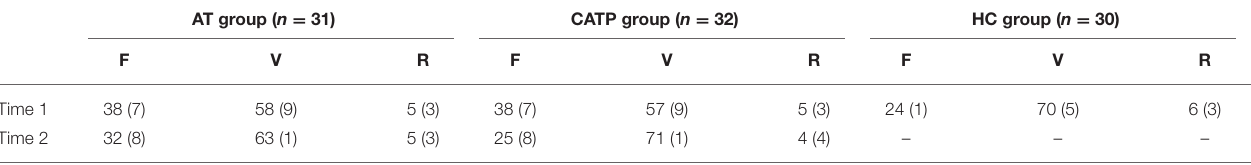
TABLE 2 | Face–vignette task performances (%, SD) among the AT group, CATP group, and healthy control group. AT group ( n =